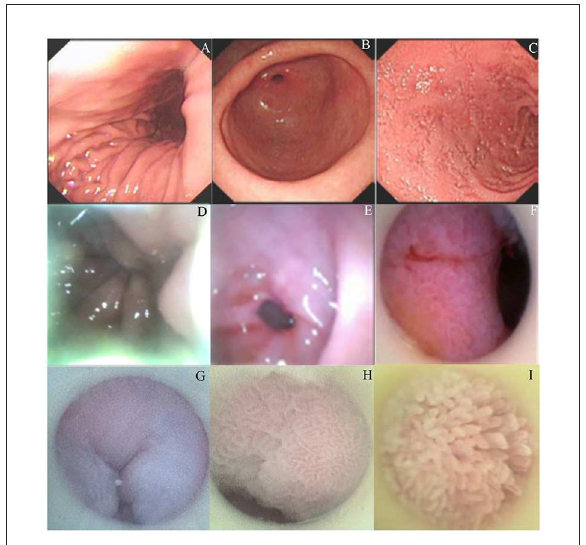
FIGURE2 The comparison of endoscopy examination of gastrointestinal parts via a gastroscope and an indwelling endoscope. (A) Endoscopic examination of the stomach using a gastroscope. (B) Endoscopic examination of the pylorus using a gastroscope. (C) Endoscopic examination of the duodenum using a gastroscope. (D) Endoscopic examination of the stomach using an indwelling endoscope. (E) Endoscopic examination of the pylorus using an indwelling endoscope. (F) Endoscopic examination of the duodenum using an indwelling endoscope. (G) Endoscopic examination of the cardia using an indwelling endoscope. (H) Endoscopic examination of the gastric antrum using an indwelling endoscope. (I) Endoscopic examination of intestinal villi the duodenum using an indwelling